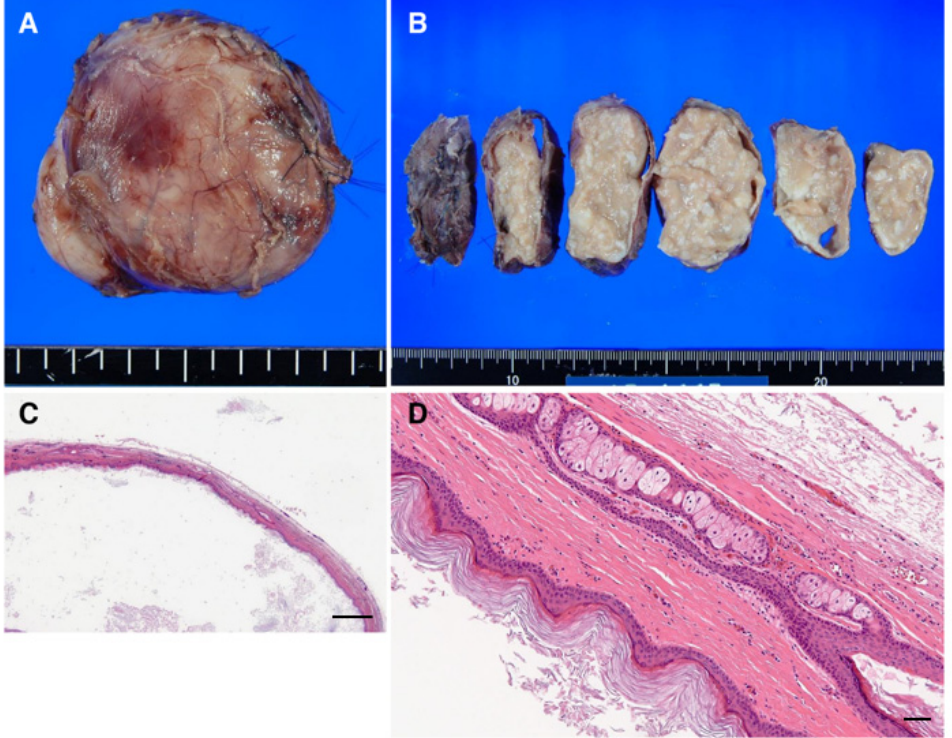
Figure 6. Histological images of epidermoid cyst. ( A , B ) Macroscopic view of epidermoid cyst. ( C ) Cyst with keratinized squamous epithelium (H-E × 20, Bar 100 μ m). ( D ) A keratinized substance was found in the cyst cavity (H-E × 200, Bar 100 μ m).